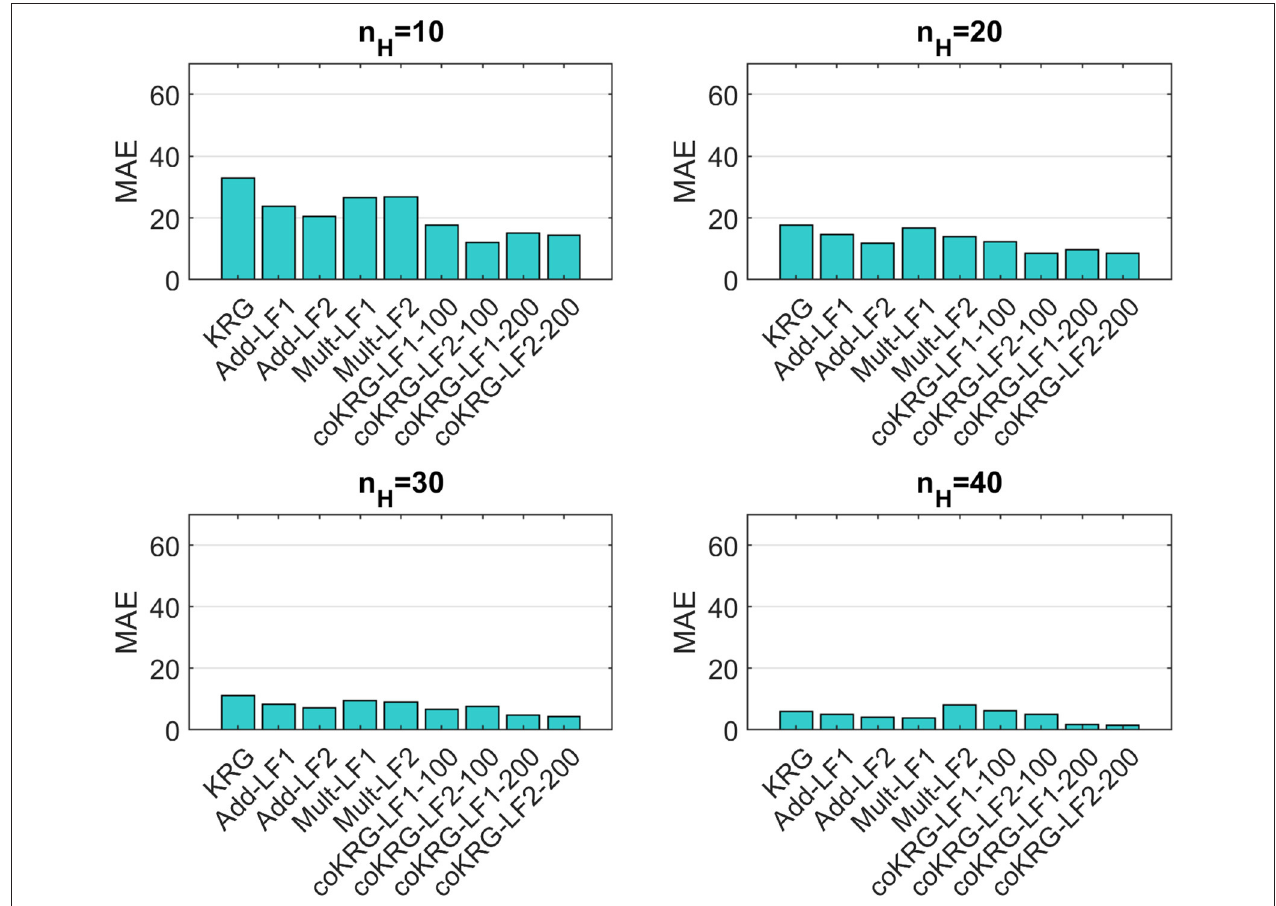
FIGURE 5 | Comparisons of all methods on the average value of the MAE performance metric for various training sample